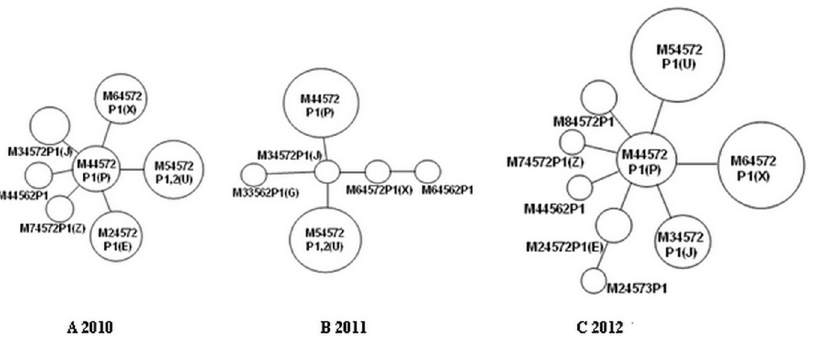
Figure 2. Minimum spanning trees for Mycoplasmapneumoniae detected in Beijing, 2010 (n=20, A), 2011 (n=21, B), and 2012 (n=75, C). Each circle represents a unique genotype. The size of each circle illustrates the proportion of specimens with that genotype. The smallest circle in each tree represents one specimen. Two adjacent circle connected by a line had a single locus variant. doi:10.1371/journal.pone.0064607.g002 PLOS ONE |